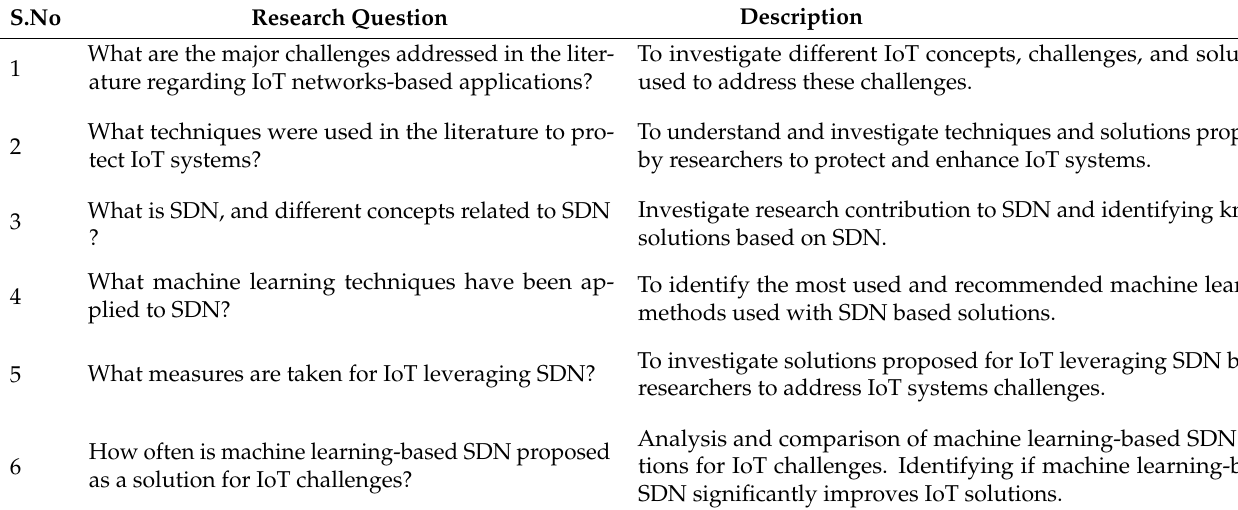
Table 1. Research questions for the topical